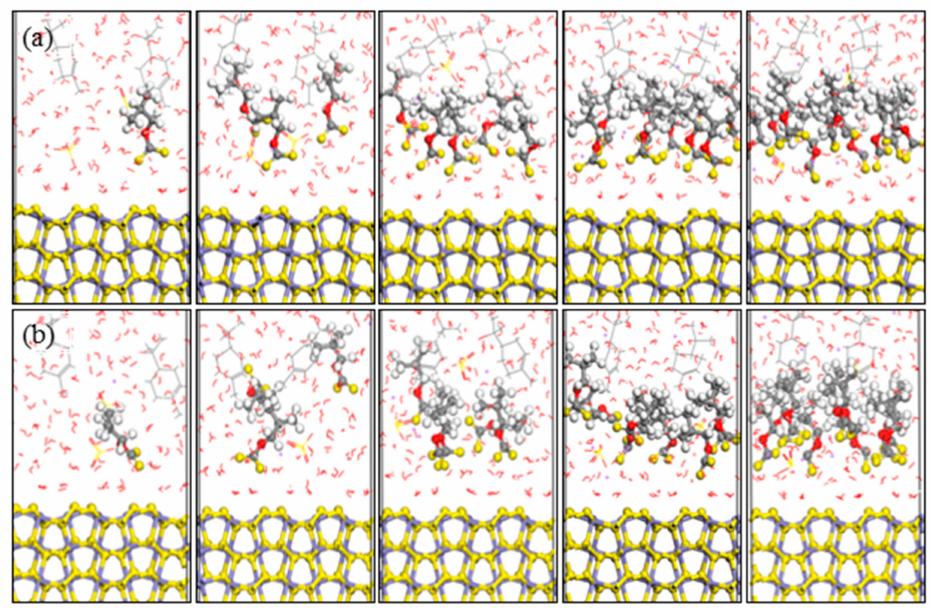
Figure 8. Equilibrium configurations of different isobutyl xanthate concentrations on pyrite surface in flotation chemistry ( a ) NVT; ( b ) NPT; (Color codes: red = O, white = H, yellow = S, grey = C, iron grey = Fe, purple = Na, brown = Cu; The above pictures is 1, 3, 5, 8, and 10 numbers of xanthate, respectively).